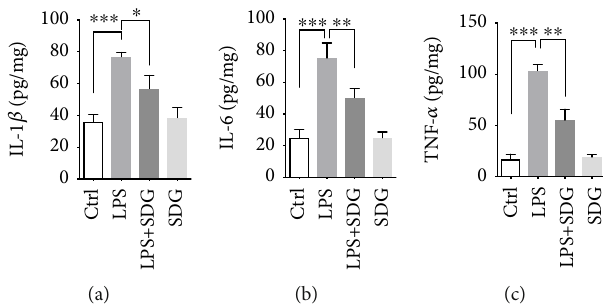
Figure 4: SDG alleviates LPS-induced in fl ammation response in HUVECs. (a – c) Semiquantitative analysis of the relative levels of IL-1 β , IL-6, and TNF- α using ELISA. Error bars represent mean ± s : d . ∗ , ∗∗ , and ∗∗∗ represent p < 0 : 05 , p < 0 : 01 , and p < 0 : 001 , respectively. All experiments were performed in triplicate. LPS: lipopolysaccharide; SDG: secoisolariciresinol diglucoside.